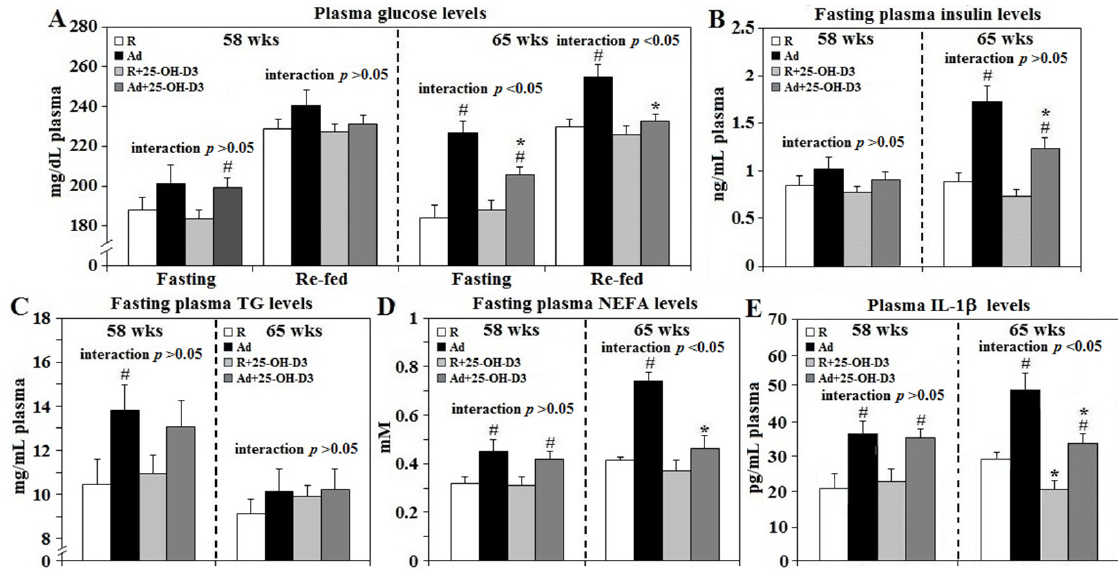
Figure 1. Plasma glucose, insulin, TG, NEFA, and IL-1 β concentrations of broiler breeder hens provided with restricted (R) or ad libitum (Ad) feed intake. At age of 58 and 65 weeks (wks), 6 hens from each group were randomly selected for blood collection for plasma glucose, insulin, triacylglycerol (TG), non-esterified fatty acid (NEFA), and interleukin-1 β (IL-1 β ) analysis ( A – E , respectively, n = 6). #; significant difference by Ad-feed intake (vs. corresponding R hens, p < 0.05), *; significant difference by 25-OH-D 3 (vs. R- or Ad-hens, p < 0.05). 25-OH-D 3 : 25-hydroxycholecalciferol.